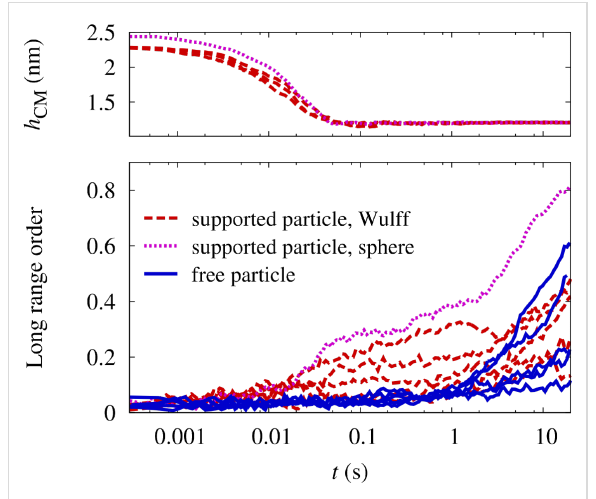
Figure 5: Bottom panel: Evolution of LRO parameter with annealing time at 1000 K in free and supported FePt nanoparticles of D = 5 nm and identical Fe–substrate and Pt–substrate interactions. Top panel: Position of the center of mass of supported FePt nanoparticles, measured in height over the substrate h CM .